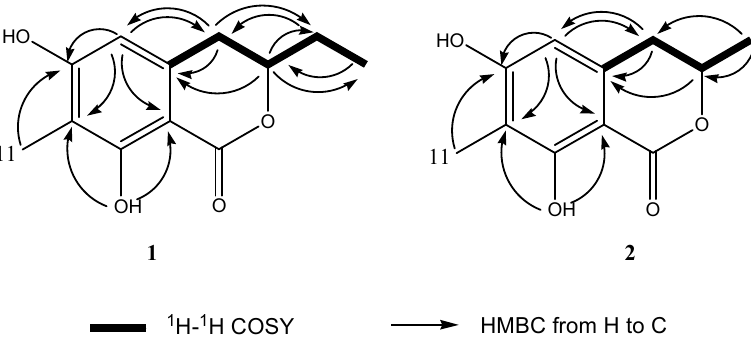
Figure 4. Key 1 H 1 H COSY and HMBC correlations of compounds 1 and 2 .